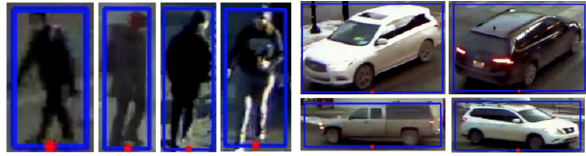
Figure 1. Detection bounding boxes of pedestrians (left) and vehicles